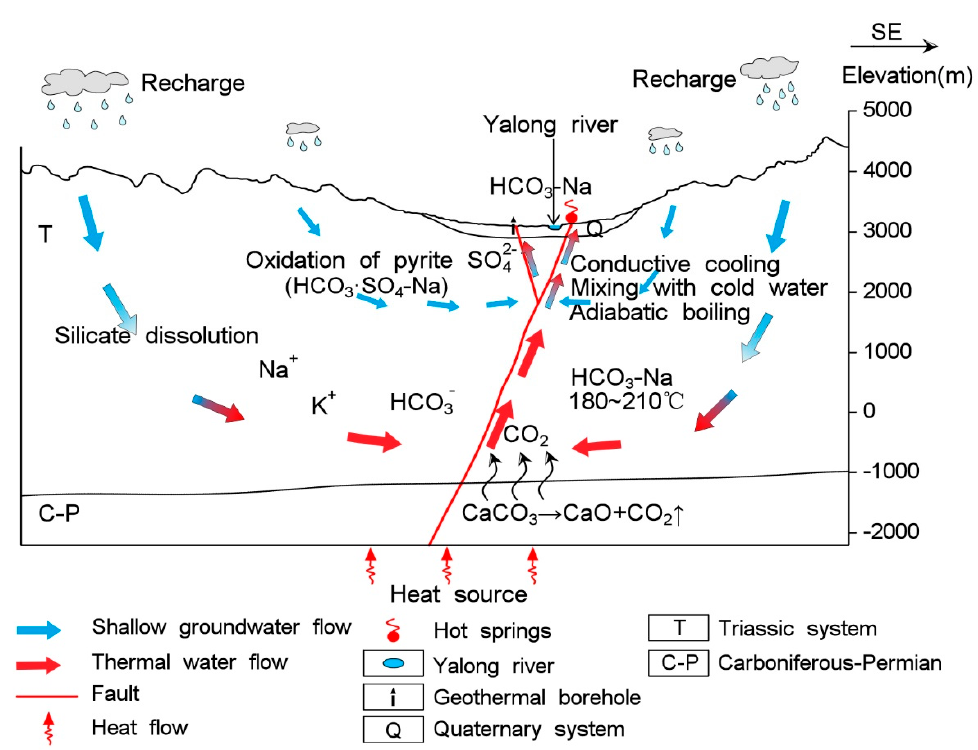
Figure 15. Schematic diagram of the conceptual model of the Ganzi geothermal field.